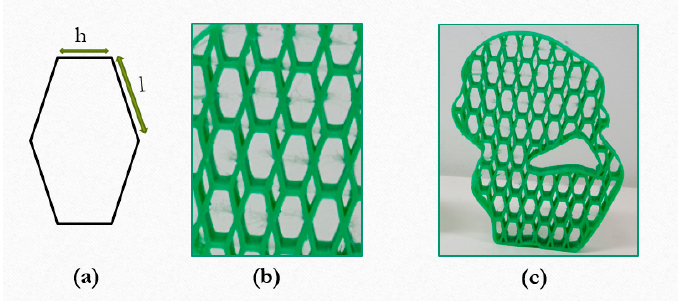
Figure 5. The elongated hexagonal element, ( a ) element geometry ( b ), ( c ) outputs.